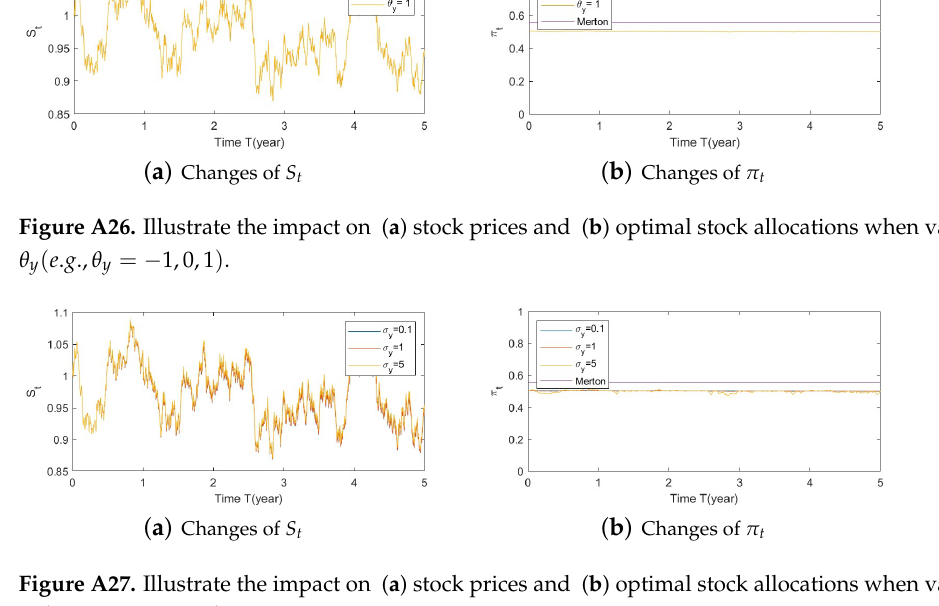
Figure A27. Illustrate the impact on ( a ) stock prices and ( b ) optimal stock allocations when varying σ y ( e . g ., σ y = 0.1,1,5 ) .